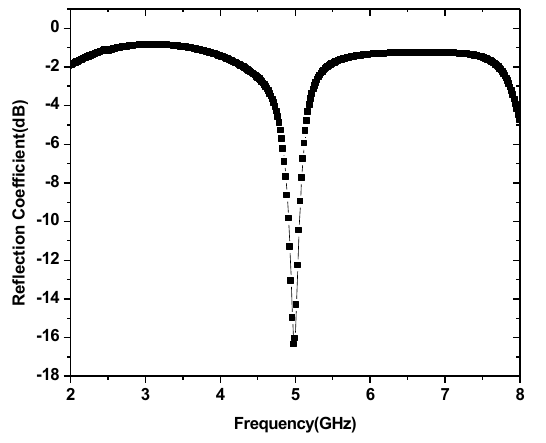
Figure 9: Reflection coefficient of 1×2 MTPAA at 4.98 GHzGHz